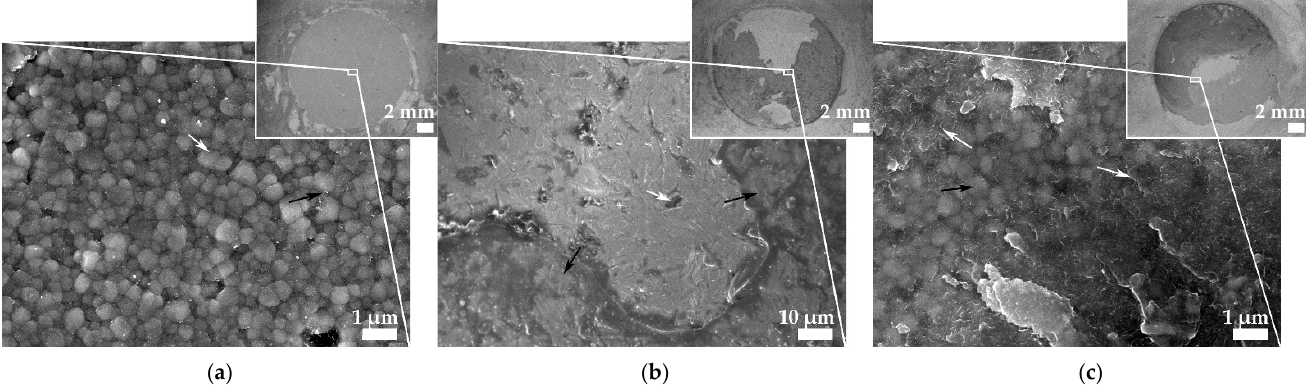
Figure 4. Light microscopy micrographs (insets) and SEM micrographs of different failure modes of representative specimens: ( a ) adhesive failure mode of AS specimen—at magnification ×3.5 complete adhesive failure is evident and at magnification ×10,000 exposed zirconia grains (white arrow) and residing cement fillers (black arrow) are observed; ( b ) mixed failure mode of APA specimen - at magnification ×3.5 a low percentage of adhesive failure is evident and, at magnification ×1000, cement remnants (black arrow), surface flaws, and sharp indentations (white arrows) caused by APA are observed; ( c ) mixed failure mode with a predominantly cohesive fracture of an NAC specimen, at magnification ×3.5 thick cement residue (white arrow), is observed with a small adhesive failure and, at magnification ×10,000, exposed zirconia grains covered with NAC residue (white arrows) are observed.